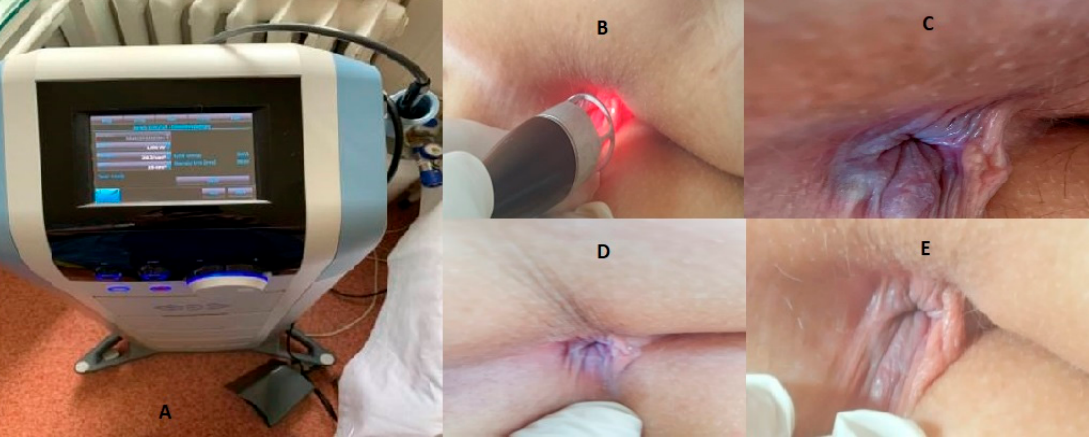
Figure 1. ( A ) Laser BTL-6000; ( B ) laser probe and laser treatment applied transcutaneously and on the external orifice of the fistula; ( C ) day 3; ( D ) day 5; ( E ) day